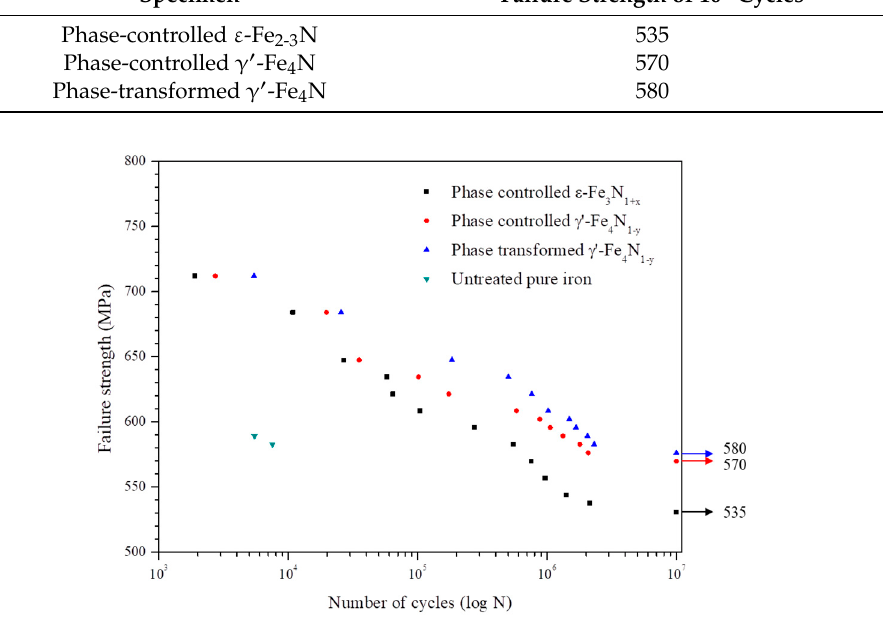
Table 3. Fatigue limit stress of the nitride phases formed on surface of pure iron after gas nitriding. Specimen